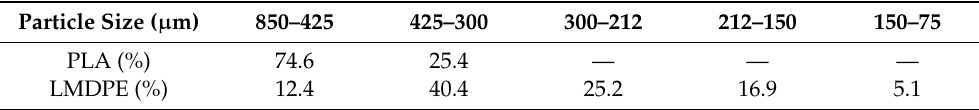
Table 1. Particle size distribution of the polymers. PLA: Poly(lactic acid); LMDPE: Linear medium density polyethylene.